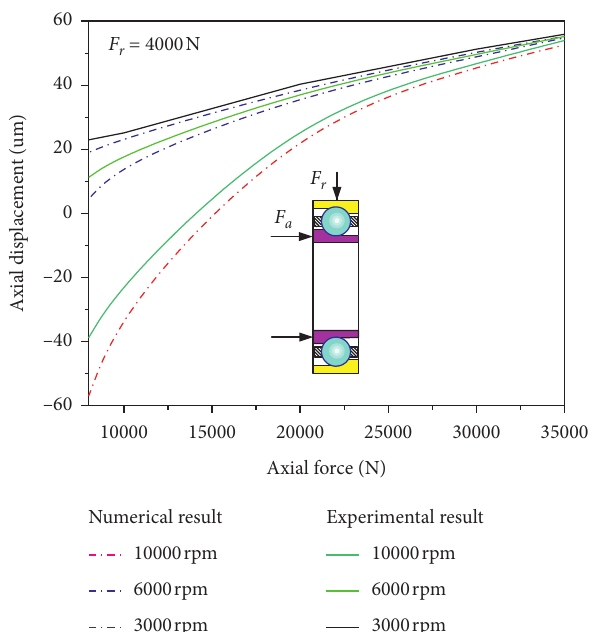
Figure 16: The contact force between outer ring and rolling